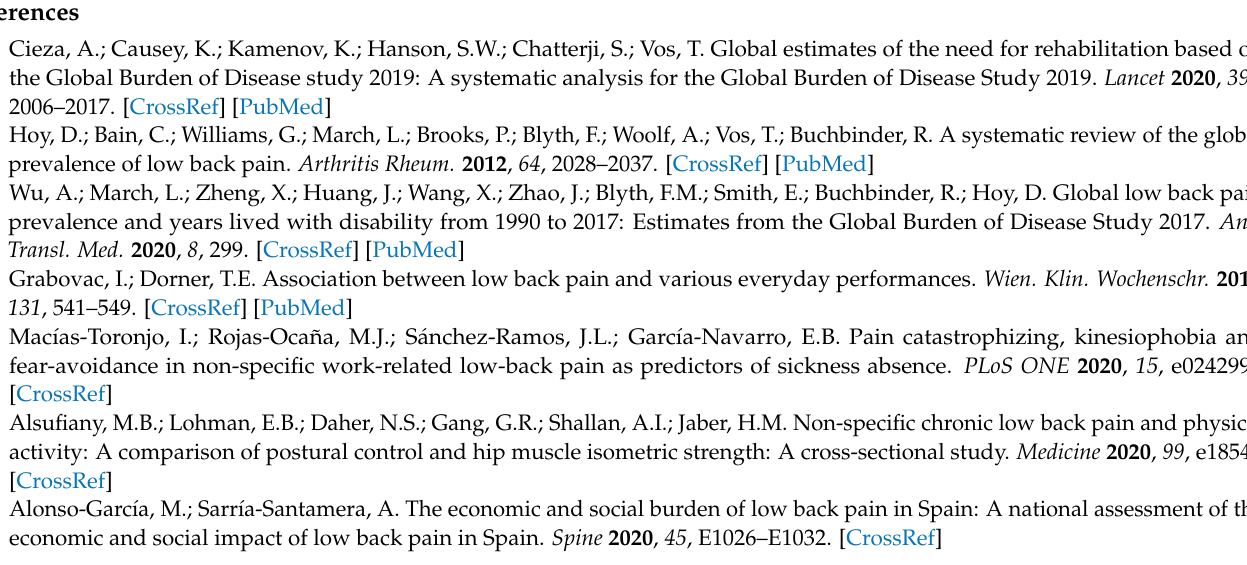
Figure S1. Bland-Altman plots of the SFT and the two balance tests for participants divided by sex. OE: online evaluation; IPE: face-to-face evaluation; ULoA: upper limit of agreement; LLoA: lower limit of agreement. The shaded areas represent the confidence interval limits for the mean and agreement limits. Supplementary Figure S2. Bland-Altman plots of the SFT and the two balance tests for participants divided by sex. OE: online evaluation; IPE: face-to-face evaluation; ULoA: upper limit of agreement; LLoA: lower limit of agreement. The shaded areas represent the confidence interval limits for the mean and agreement